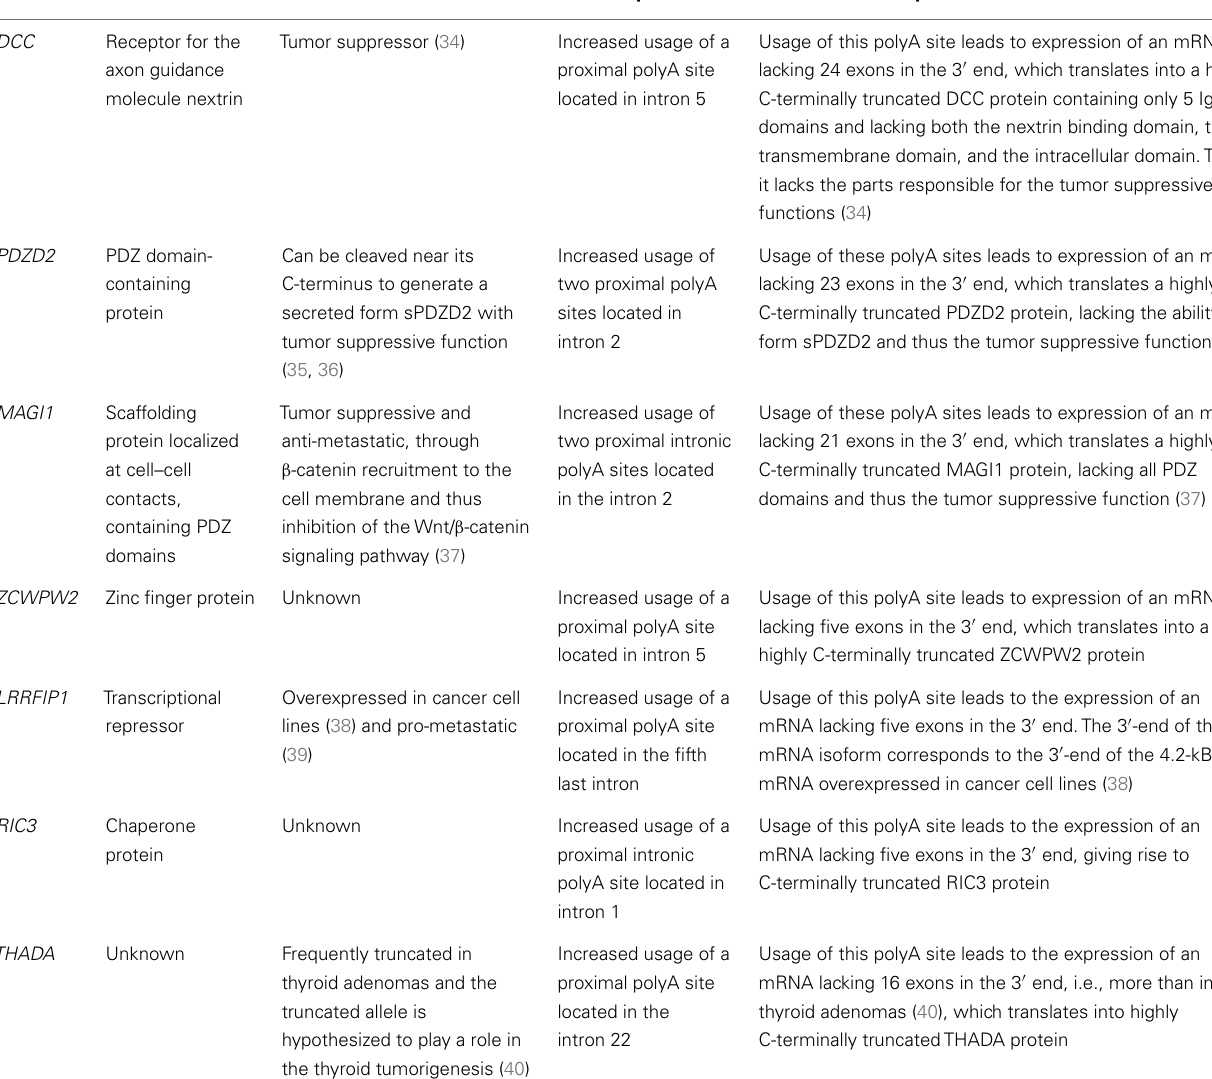
Table 4 | Genes with CR-APA specific to the